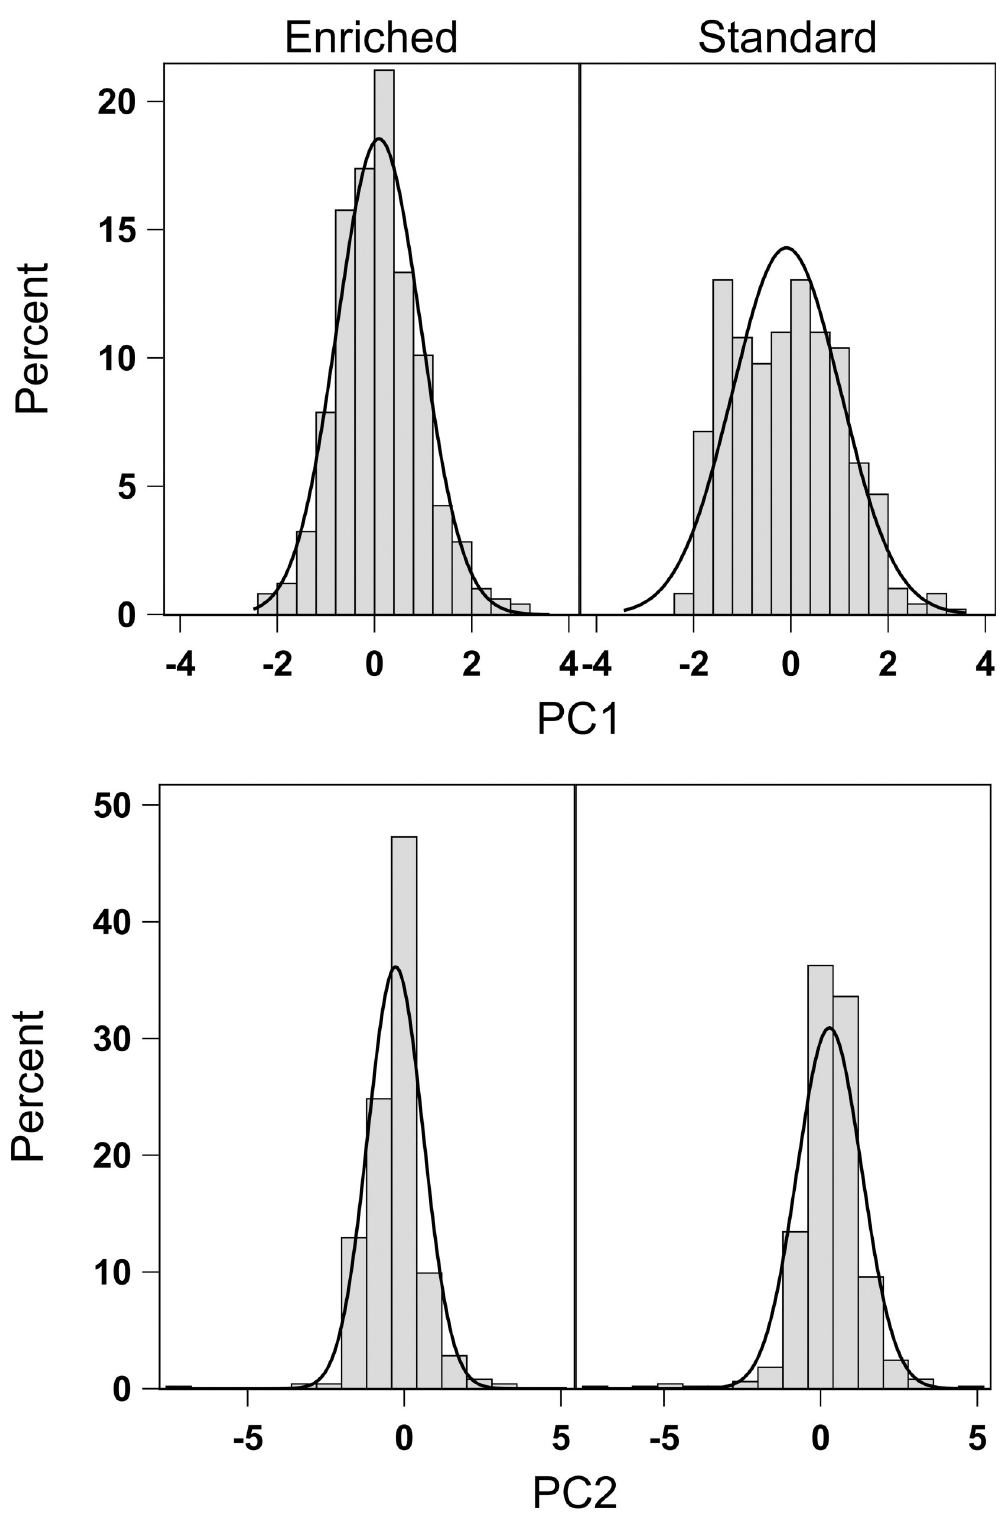
Fig 4. Frequency distributions (with normality curves) of principal component scores depicting migration activity in enriched- ( n = 495) and standard-reared fish ( n = 491). Frequency distributions of migratory activity components in enriched- and standard-reared